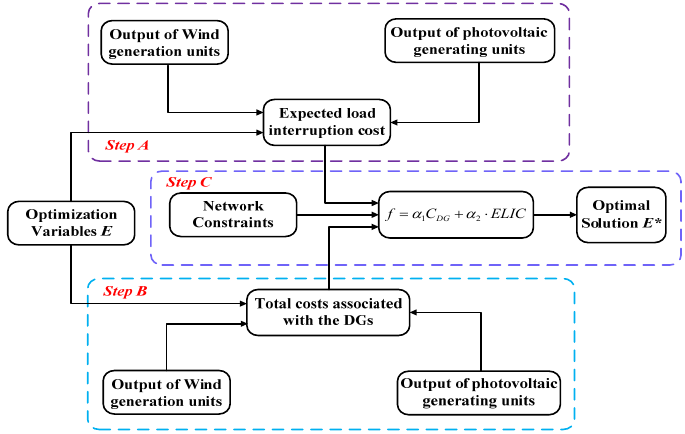
Figure 1. Flowchart of the developed chance constrained programming (CCP)-based method for optimal siting andsizing of distributed generators(DGs) in distribution systems.